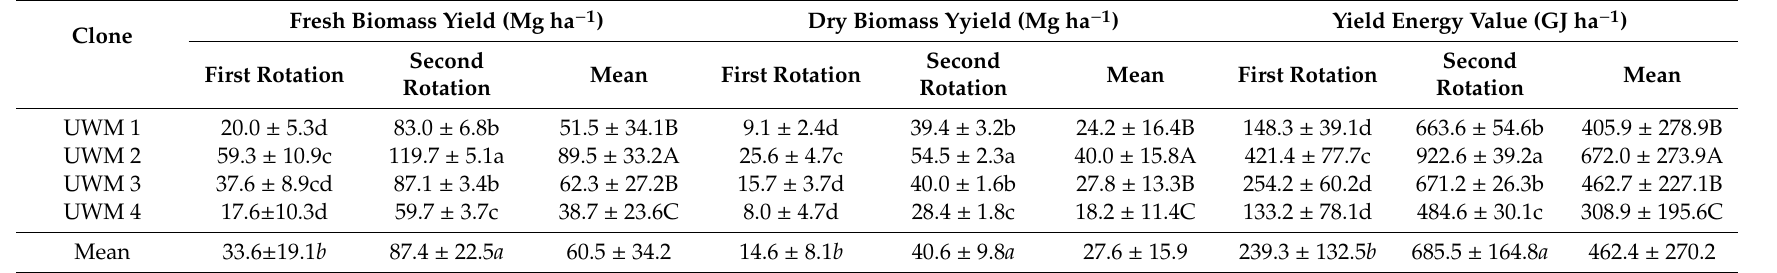
Table 2. Yield and yield energy value of four poplar clones in two consecutive 4-year harvest